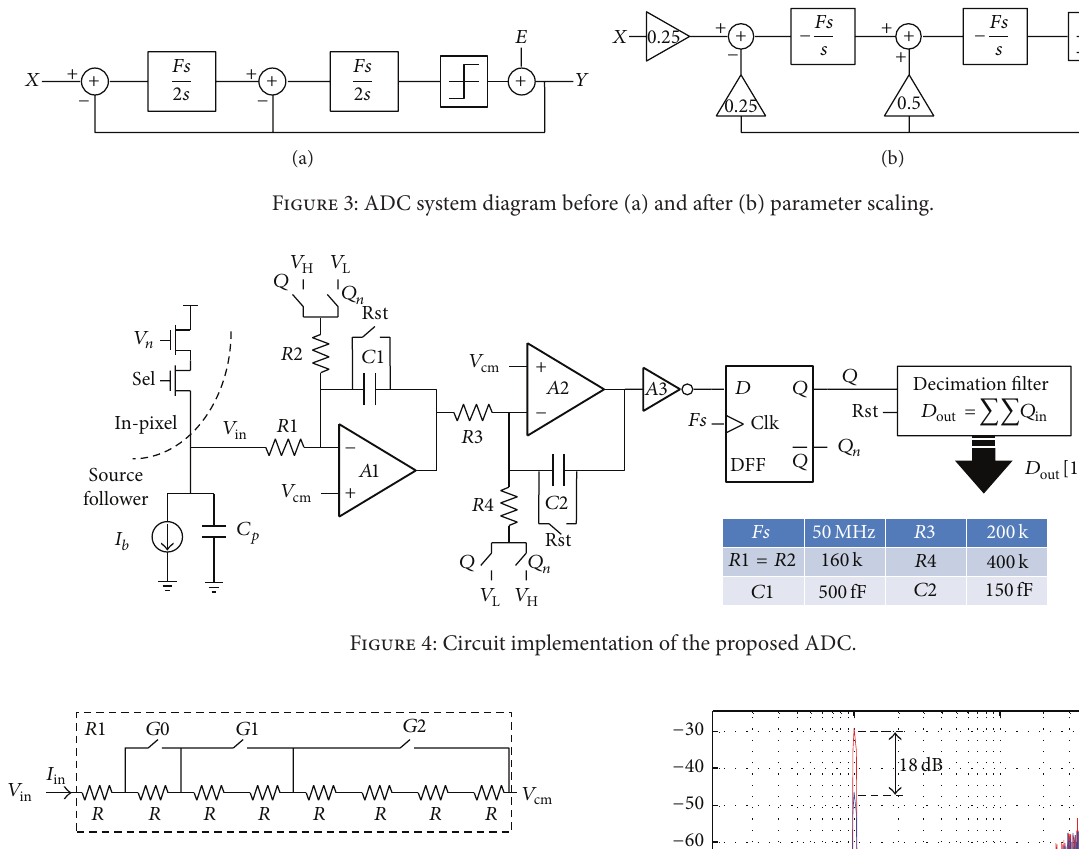
Figure 5: Implementation of the input resistor 𝑅1 .